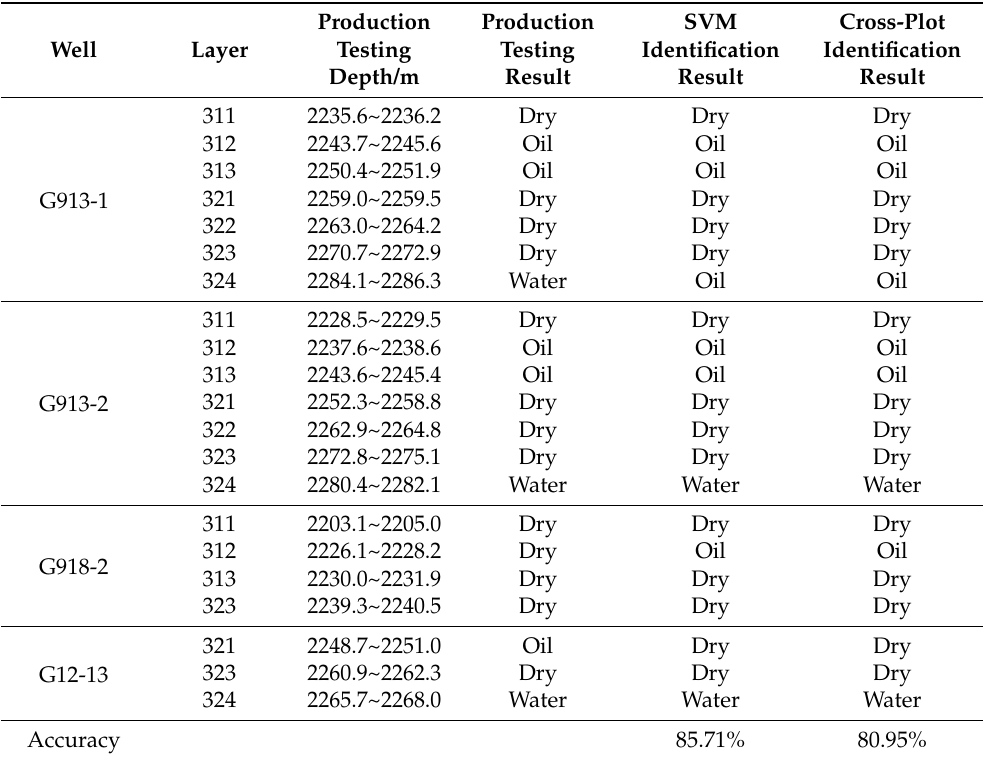
Figure 7. Crossplot of AC and RT of thin oil layer of Es33. Table 2. Comparison table of identification results of test